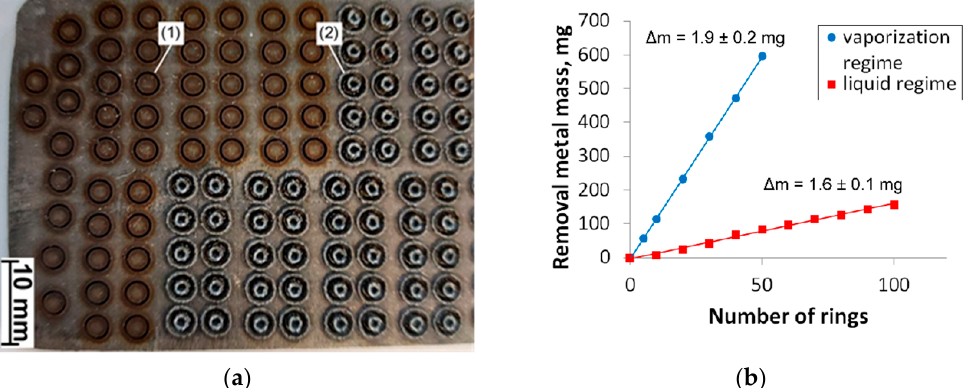
Figure 13. ( a ) Photo of a metal plate with applied annular grooves and ( b ) graphs of the dependence of the mass of the removed material on the number of formed grooves on the surface of the sample, where ( 1 ) is a top view of the annular groove obtained in the evaporation mode, ( 2 ) is the annular groove in the liquid phase mode.